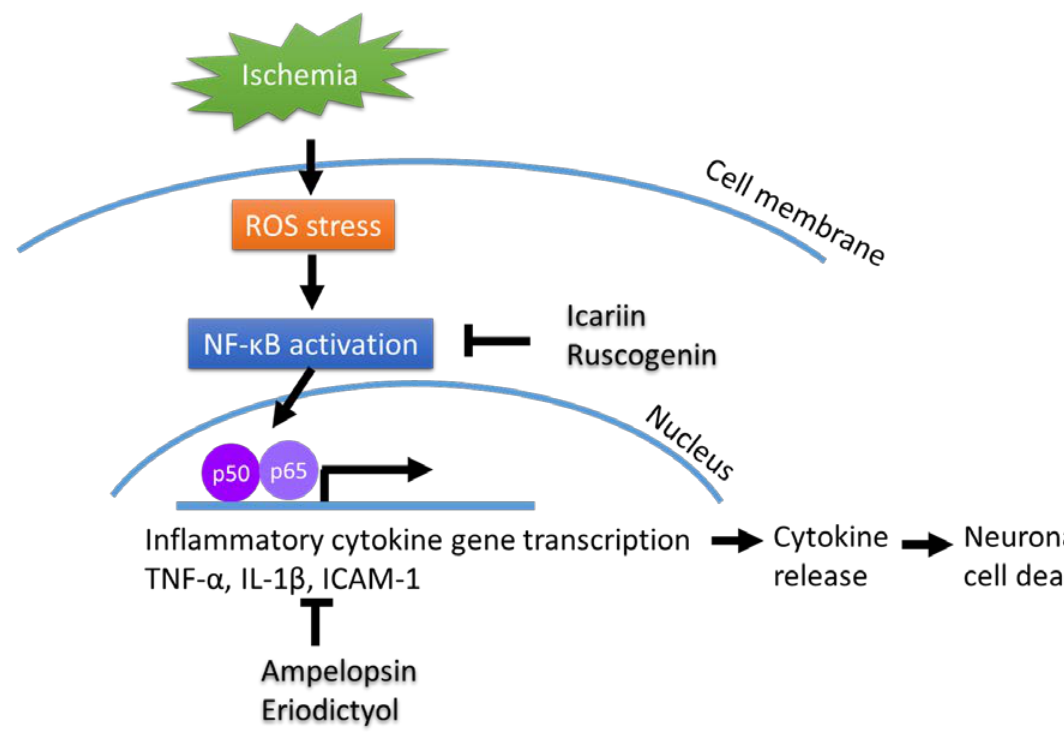
Figure 1. Chinese herbal compound decrease NF- κ B activation and cytokines release after ischemia injury.